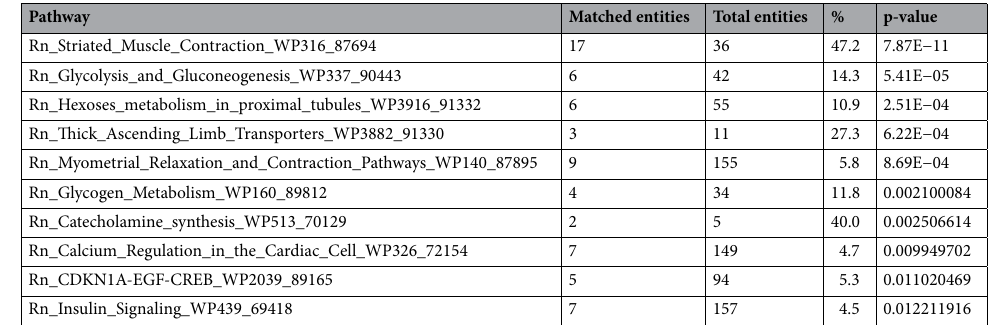
Table 1. Top 10 pathways that were up-regulated by 1.5 fold or more in the post-heartbeat group compared with those in the pre-heartbeat group.